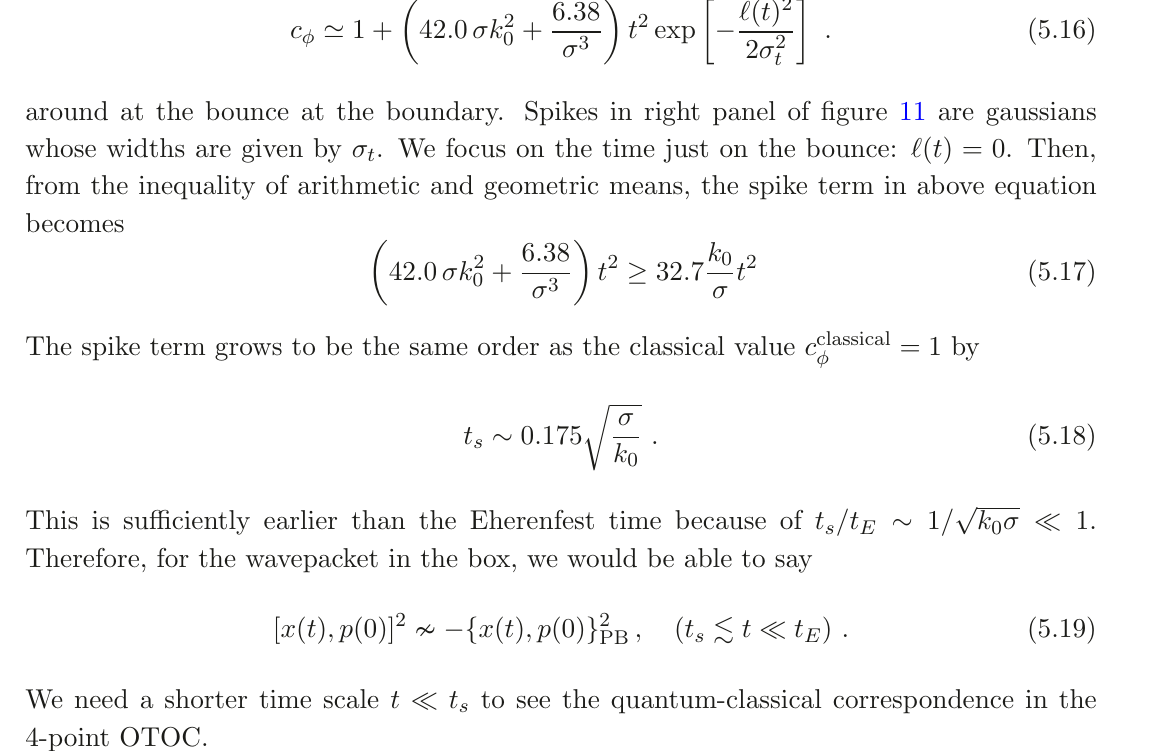
(2 N + 1) is the difference −